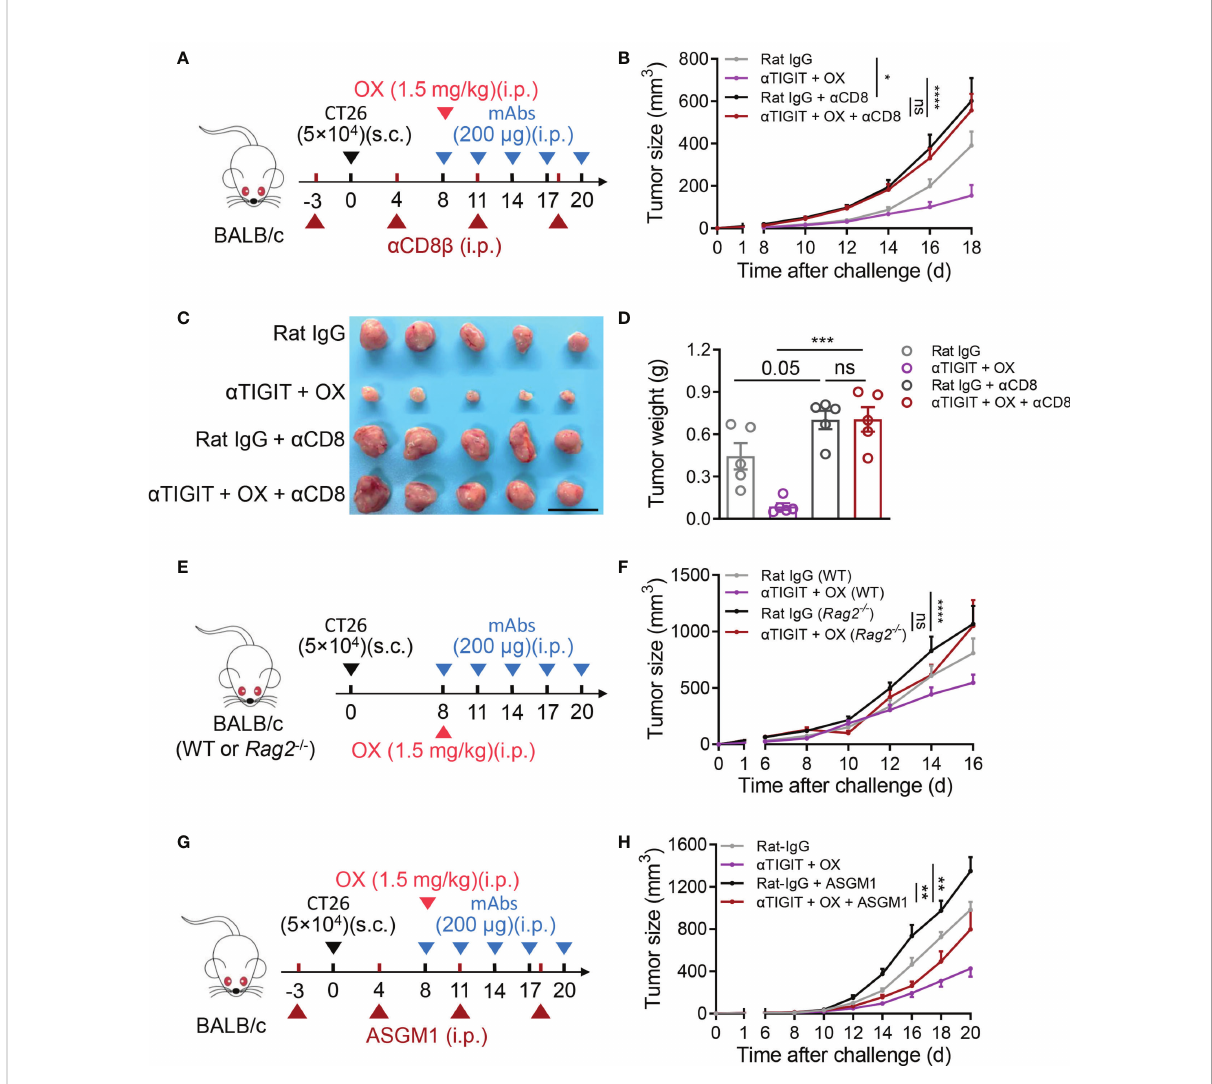
FIGURE 5 De fi ciency of CD8 + T cells impairs synergistic antitumor ef fi cacy of low-dose oxaliplatin and anti-TIGIT. (A) , Experimental scheme for CT26 colon cancer model used in (B – D) . Mice were given injection of Rat IgG or anti-TIGIT (10 mg/kg) combined with OX (1.5 mg/kg) intraperitoneally (i.p.) at various times after injection of 5×10 4 CT26 cells subcutaneously (s.c.) on day 0 and weekly injection of anti-CD8 b mAbs intraperitoneally (i.p.) on day -3. (B) , Tumor size measurement at each time point (n= 9 mice per group). (C) , Representative photograph and (D) weight of tumor on day 18 after challenge. Scale bar represents 2 cm. (n= 9 mice per group). (E) , Experimental scheme for CT26 colon tumor model used in (F) BALB/c WT or BALB/c Rag2 -/- mice were given injection of Rat IgG or anti-TIGIT (10 mg/kg) combined with OX (1.5 mg/kg) intraperitoneally (i.p.) at various times after injection of 5×10 4 CT26 cells subcutaneously (s.c.) on day 0. (F) , Tumor size measurement at each time point (n= 9 mice per group). (G) , Experimental scheme for CT26 colon tumor model used in (B) Mice were given injection of Rat IgG or anti-TIGIT (10 mg/kg) combined with OX (1.5 mg/kg) intraperitoneally (i.p.) at various times after injection of 5×10 4 CT26 cells subcutaneously (s.c.) on day 0 and weekly injection of anti- ASGM1 intraperitoneally (i.p.) on day -3. (H) , Tumor size measurement at each time point (n = 8-10 mice per group). Data were representative of at least two independent experiments. Error bars represent means ± SEM. Statistical signi fi cance was determined using two-way ANNOVA (B, F, G) , one-way ANOVA followed by Tukey ’ s multiple-comparisons (D) . ns, p > 0.05; *p < 0.05; **p < 0.01; ***p < 0.001 and ****p <